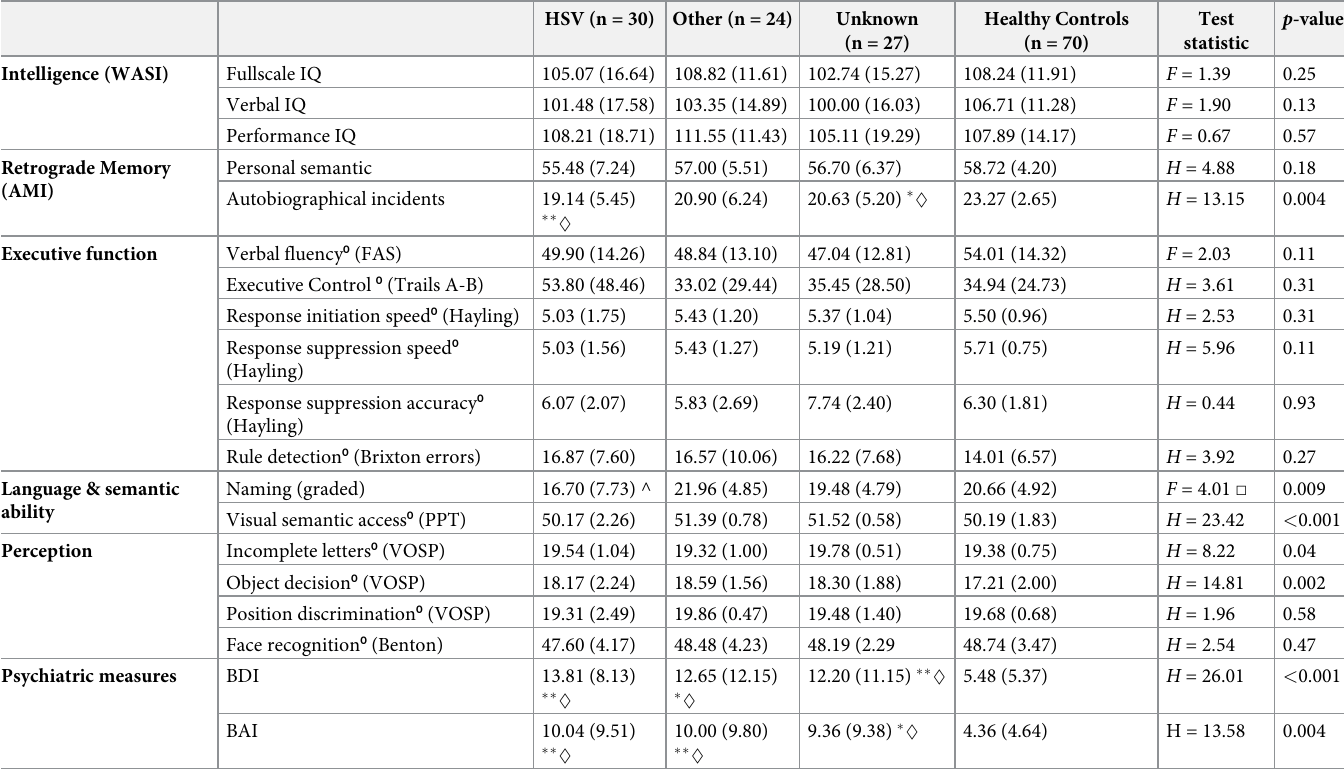
Table 6. Long-term neuropsychological and psychiatric assessment scores in the long-term outcome